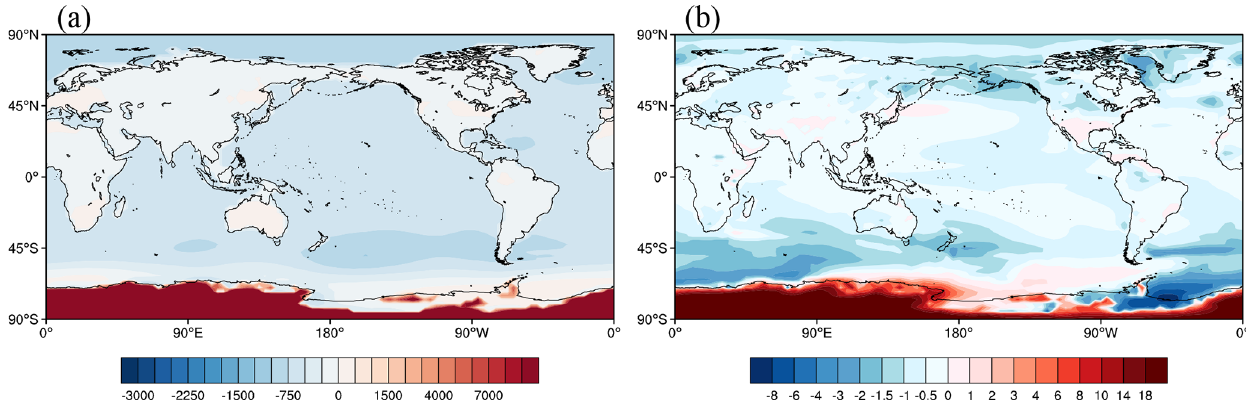
Figure 10. Spatial distribution of (a) the annual mean surface air pressure anomalies (units: Pa) and (b) the annual mean surface air tem- perature (units: ◦ C) between the new sensitivity experiment and the MPControl experiment. The new sensitivity experiment is similar to the − 100%EAIS experiment, except the sea level is artificially raised by a reduction of the land level (away from Antarctica) by